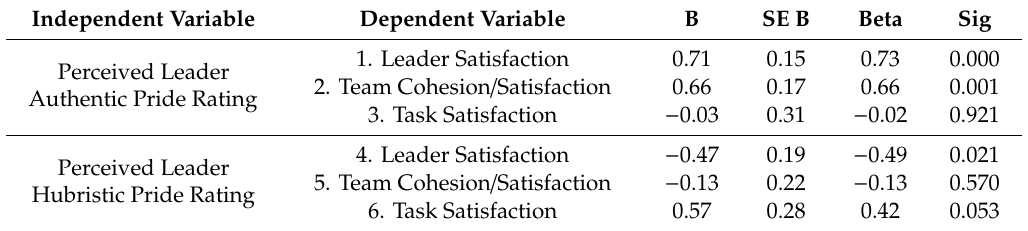
Table 4. Group level regression results with Authentic and Hubristic Pride as